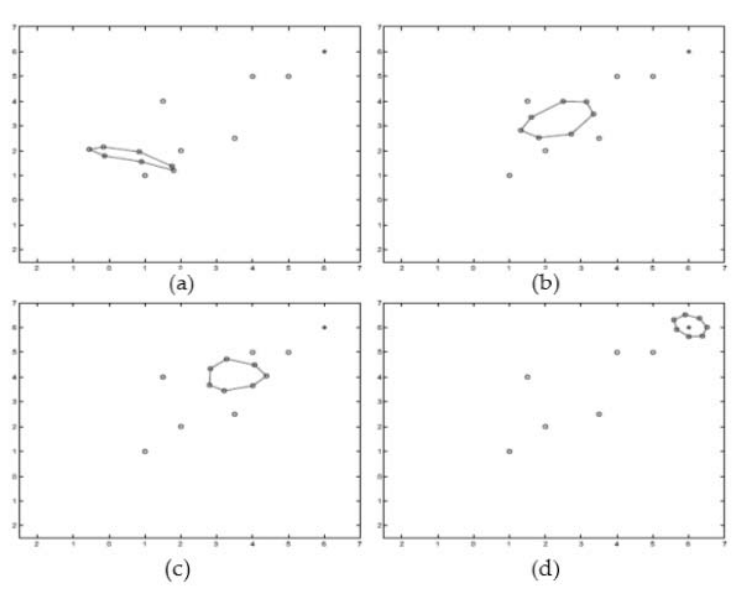
Figure 12. Simulation for multi ‐ agent system [19]. ( a – d ) Step wise formation while avoiding